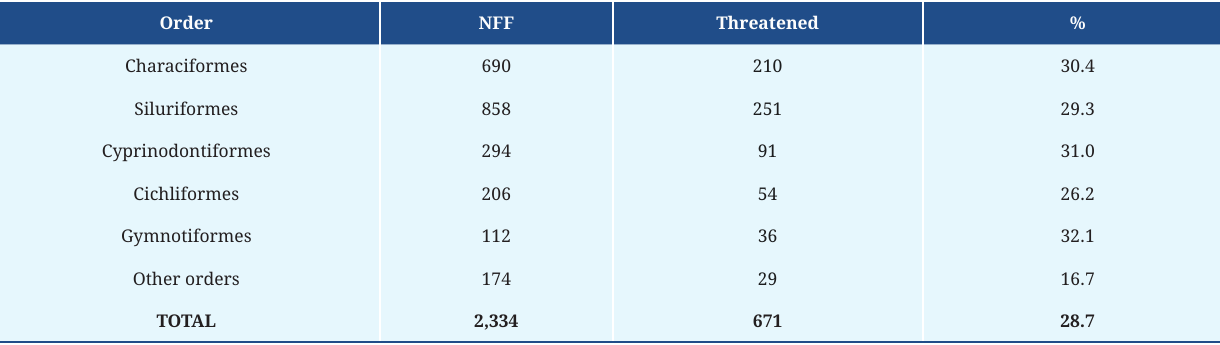
TABLE 5 | Summary of the ConR preliminary conservation assignments for 2,334 NFF Order NFF %